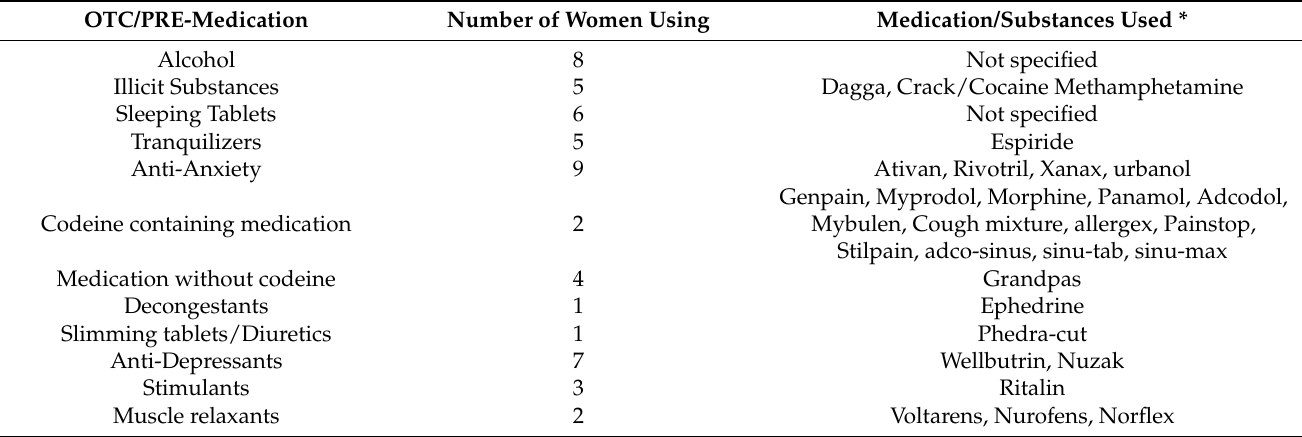
Table 3. Description of substances used by participants in the